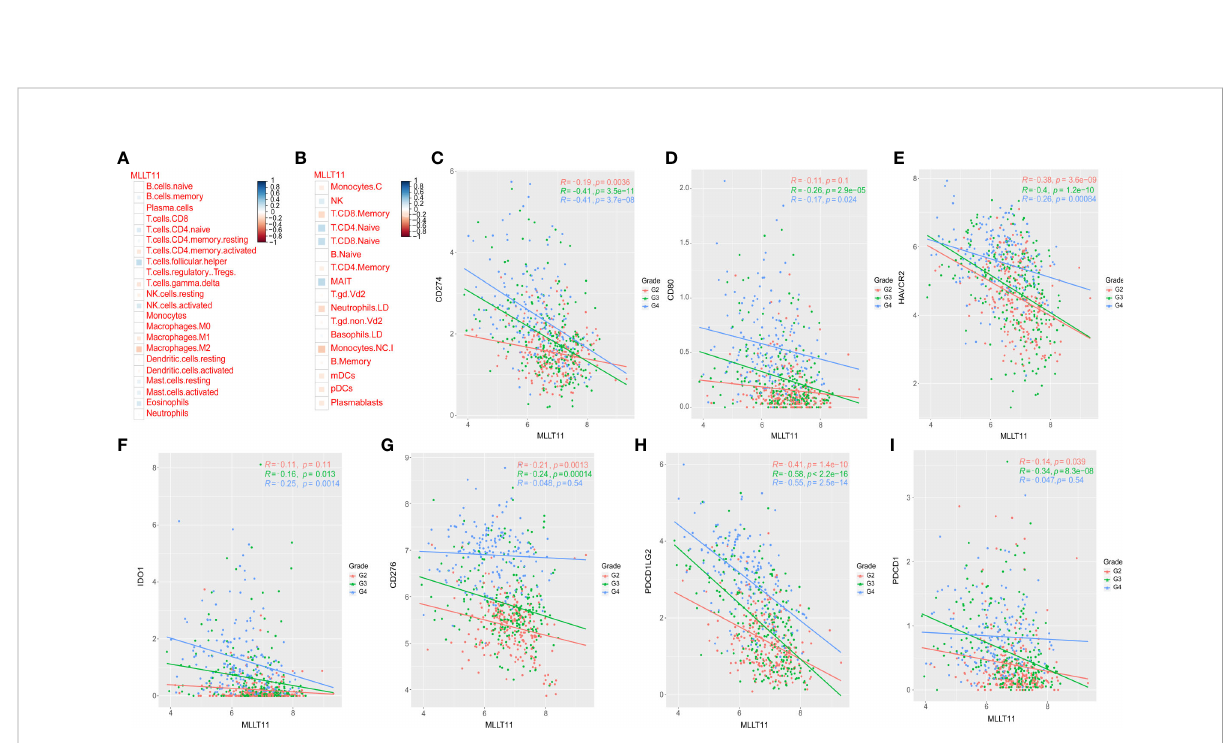
FIGURE 6 Relationships between MLLT11 expression and immune cells and immune checkpoint markers. (A, B) Correlation analysis of MLLT11 with 22 immune cells in TCGA dataset. (C – I) Correlation between MLLT11 and seven immune checkpoints in TCGA dataset. (C) CD274, (D) CD80, (E) HAVCR2, (F) IDO1, (G) CD276, (H) PDCD1LG2, (I)